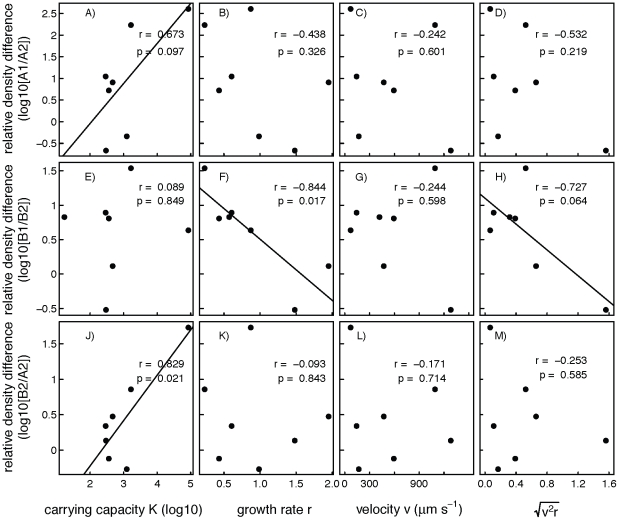
Relationship between species traits and species-specific differences in density between communities experiencing different treatments.Each point stands for a different species. Treatments follow Fig. 1. For species that went extinct in one treatment, values could not be calculated. The predicted rate of spread (D, H, J) is calculated from data on growth rate and velocity. For relationships with p<0.1, the least-square line is given.